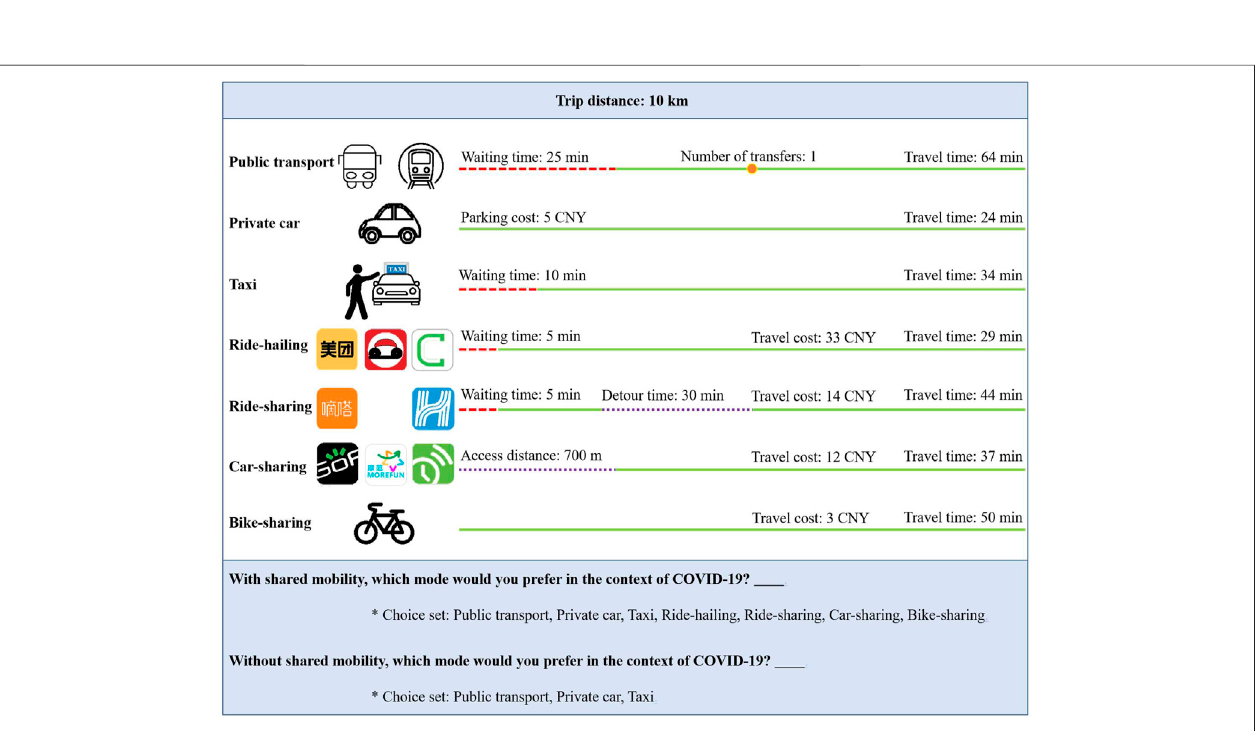
FIGURE 1 | Example of the SP